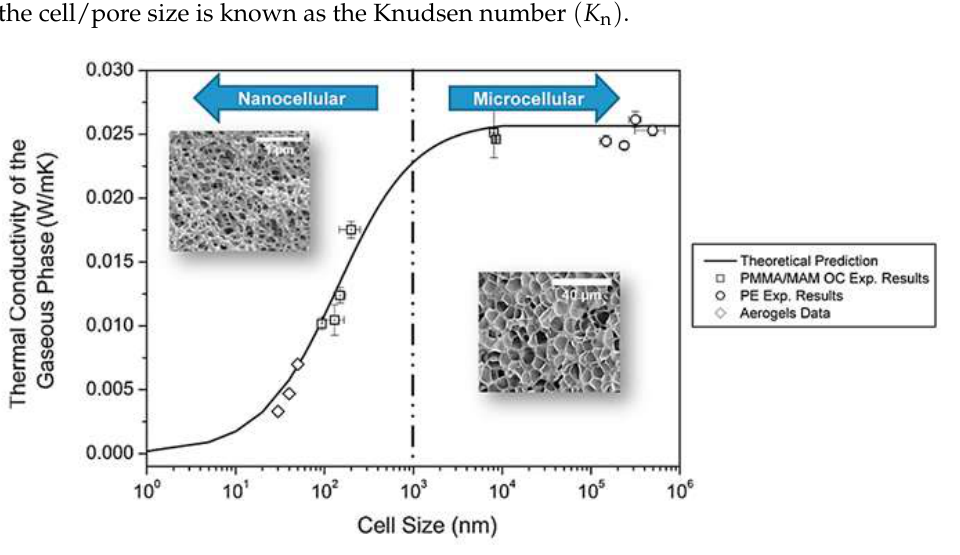
Figure 7. Gaseous thermal conductivity as a function of the cell size for different systems (Reprinted with permission from Ref. [11], Copyright © 2015, Elsevier).